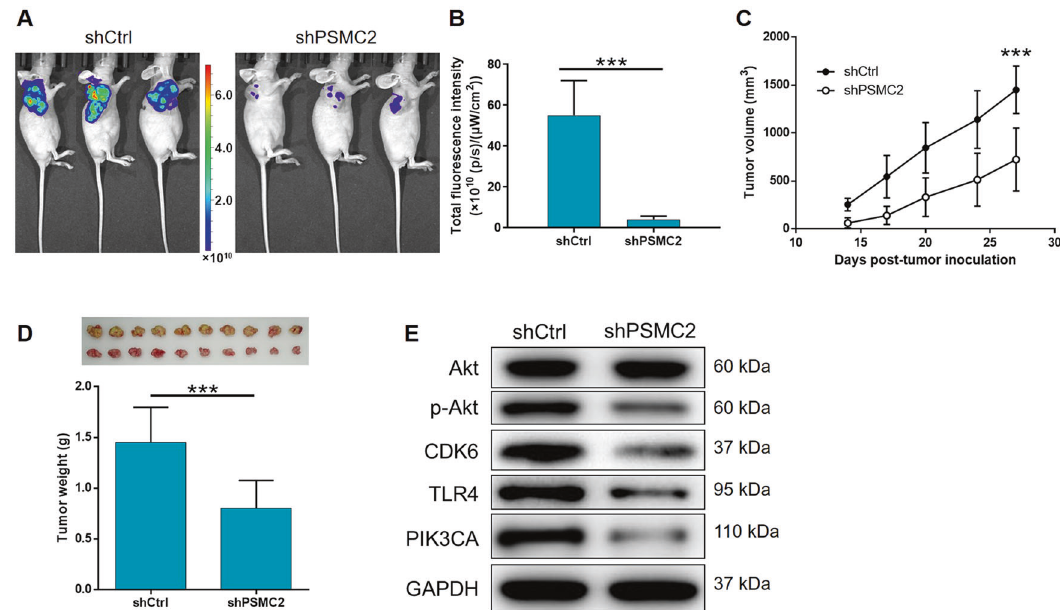
Fig. 5 PSMC2 knockdown inhibited HCC development in vivo. A In vivo imaging was utilized to estimate the tumor burden in mice of shPSMC2 and shCtrl groups at day 27 post tumor-inoculation. B The total fl uorescence intensity was analyzed to represent tumor burden in mice of shPSMC2 and shCtrl groups. C Tumor volume of mice at 14 days post injection was measured and calculated at indicated time intervals. Inset: photo of the removed tumors was taken at day 27 post tumor-inoculation. D Removed tumors were photographed and weighed. E The expression of Akt, p-Akt, CDK6, TLR4, and PIK3CA was determined by western blotting in SK-HEP-1 cells with different expression level of PSMC2. Data were shown as mean ± SD. *** P <